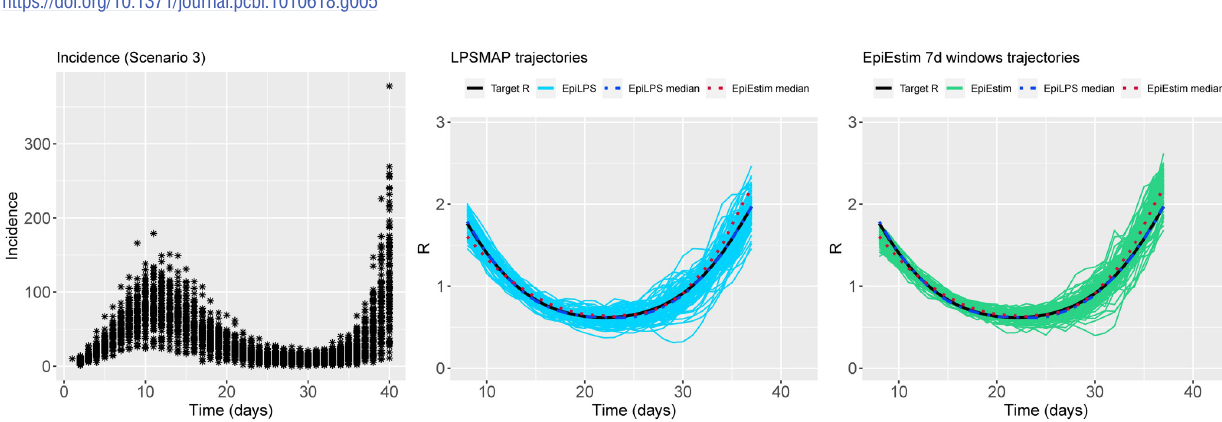
Fig 6. (Left) Simulated incidence data for Scenario 3. (Center) Estimated trajectories of R trajectories of R with EpiEstim using weekly sliding windows and R t (dashed) and EpiEstim (dotted) is also shown.